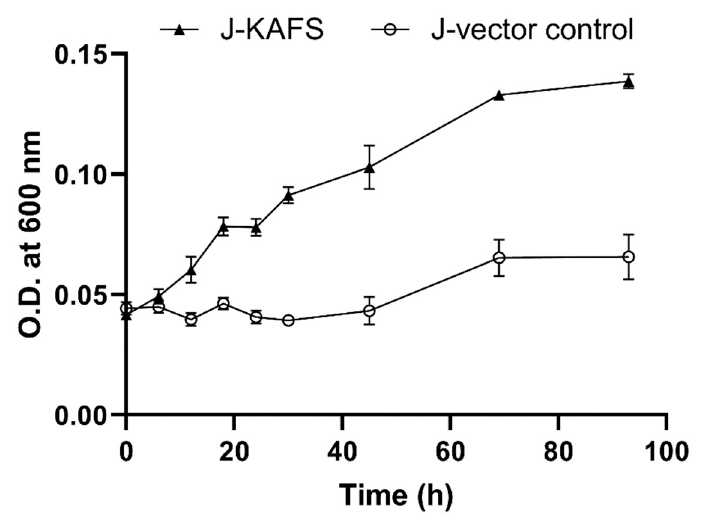
Figure 2. Growth curves of E. coli J-KAFS and J-vector control strains under anaerobic respiration conditions. Data are expressed as the means ± standard deviations, n = 3 independent biological samples.